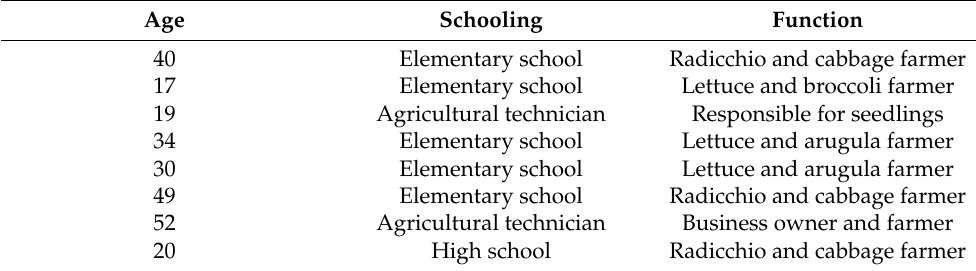
Table 5. Profiles of those who used and evaluated IndoorPlant.